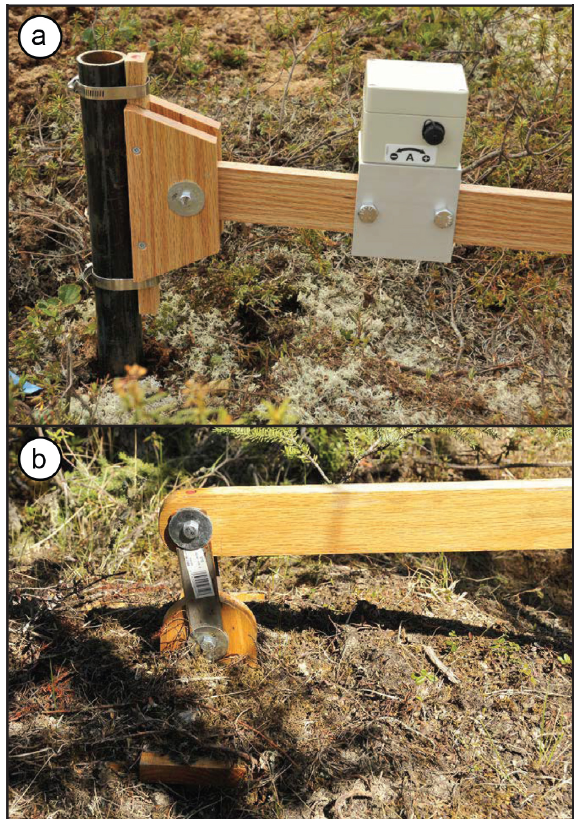
Figure 2. Detailed views on the tilt-arm logger and the attachment to the anchor pipe (a) and the double-pivot mechanism (b) just above the wooden grille inserted beneath the vegetation. See Fig. 1 for an overview image of tilt arms.